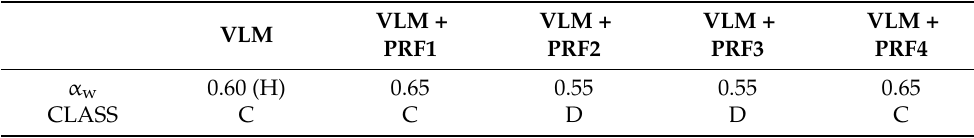
Table 5. UNE-EN ISO 11654 results and classification. Table 6. ASTM C423